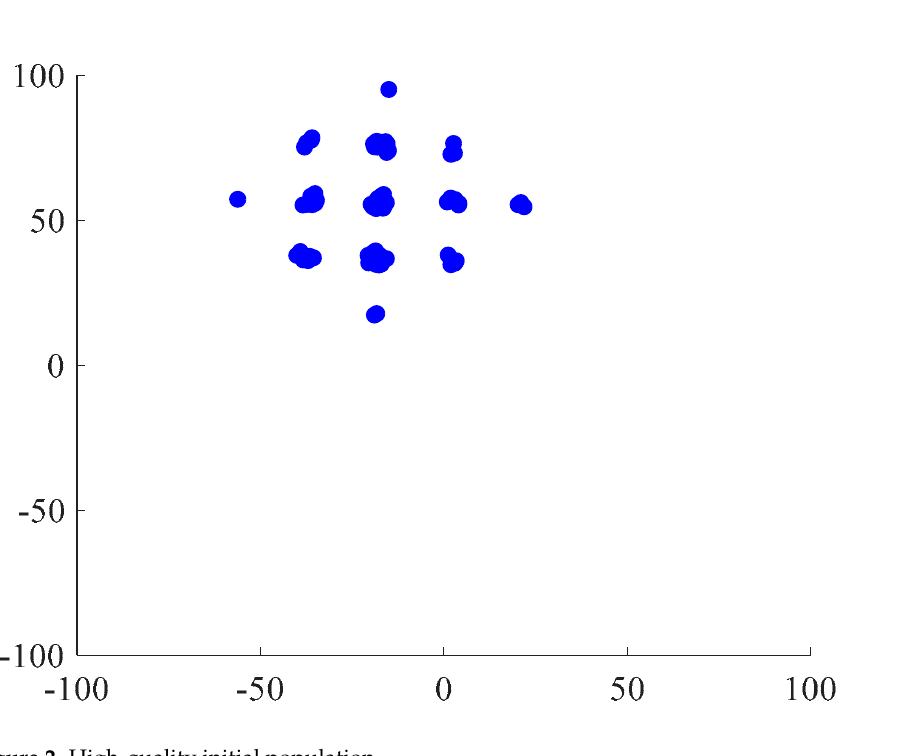
Figure 2. High-quality initial Figure 2. High − quality initial population.